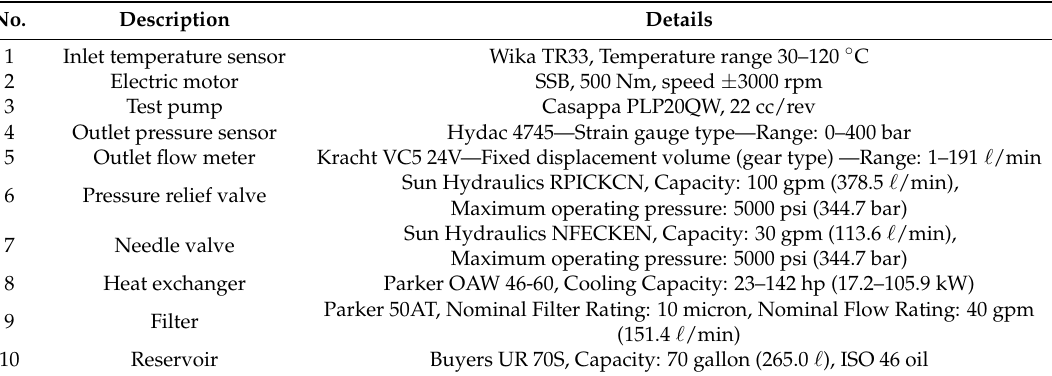
Figure 22. ( a ) Picture of semi-anechoic chamber and ( b ) hydraulic schematic. Table 4. Details of test rig components.